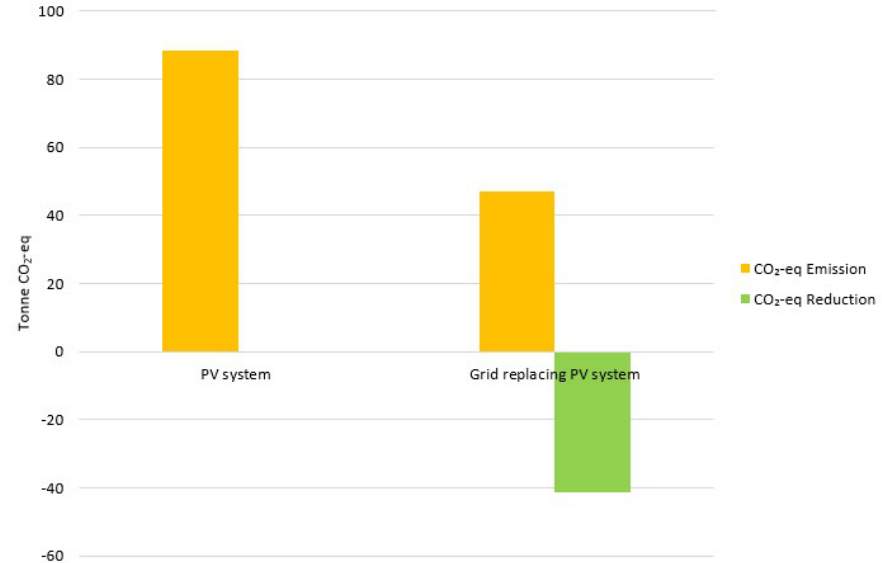
Figure 10. Impact mitigation potential of the photovoltaic